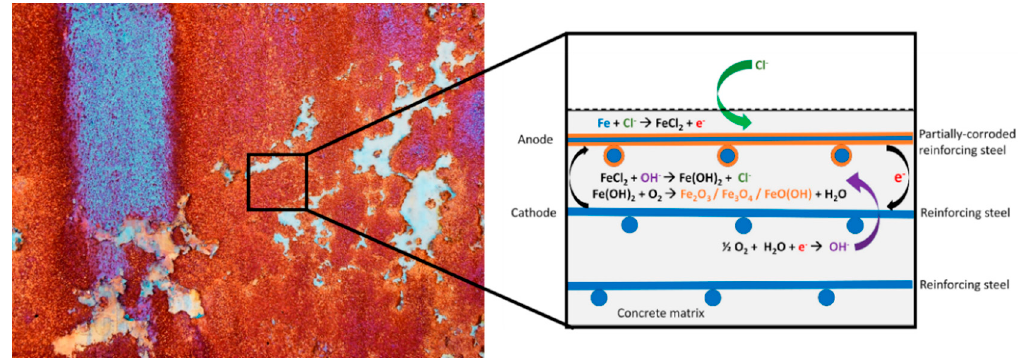
Figure 4. Scheme of the corrosion process.